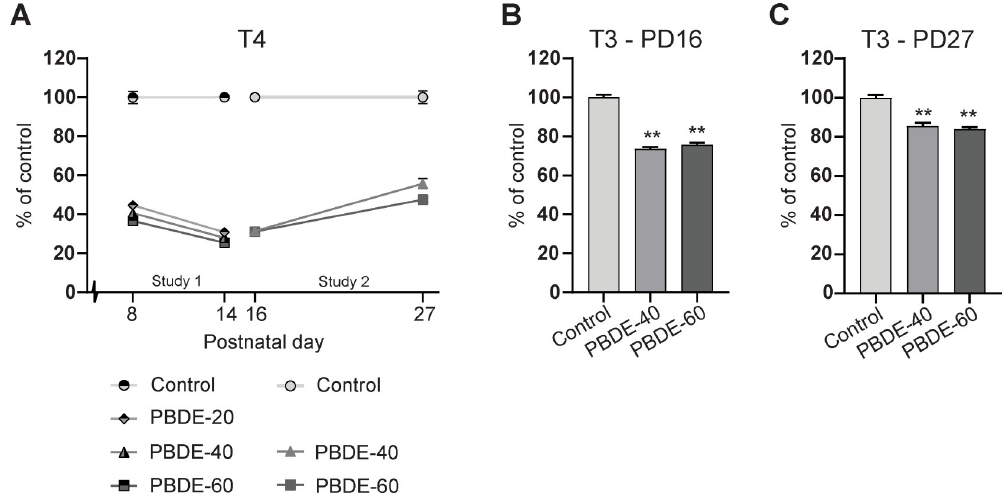
Fig 3. Pup serum T4 and T3 concentrations during postnatal development. (A) Pup serum T4 (% of control) in Study 1 and 2 covering PD8 to PD27 T4 was statistically significantly decreased at all doses at all points in time. Study 1: n = 6–8, Study 2: n = 19–21 litters. Mean + SEM. (B) Pup serum T3 concentrations PD16 and PD27 (Study 2). n = 19–21. Mean + SEM. �� p < 0.01. PBDE: polybrominated diphenyl ethers (DE-71), PD: postnatal day, T3: tri-iodothyronine, T4: thyroxine.